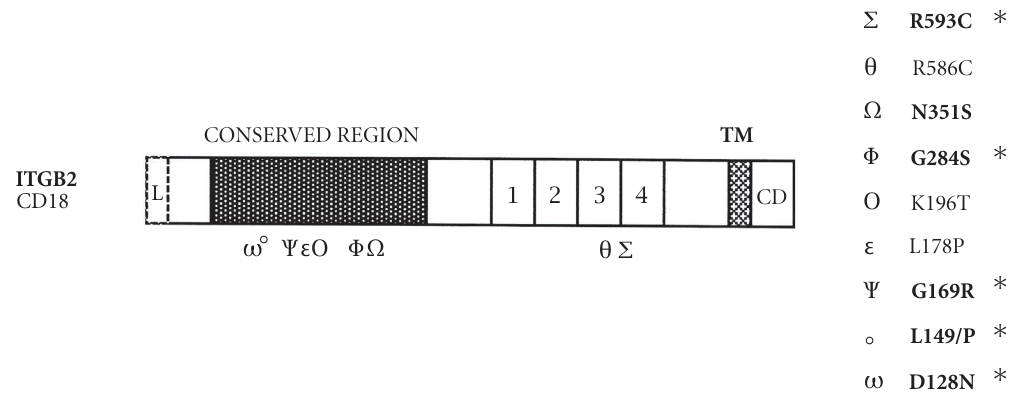
Figure 5: Localization of the missense mutations causing LAD, along the CD18 subunit: most of the mutations causing a single amino-acid substitution are clustered in the NH2 domain 250 residues that are highly conserved among the β integrins ( β 1 – β 8 ). A Greek letter indicates each point mutation. Asterisks (*) indicate potential hot spot mutations 1, 2, 3, 4 are the cystein rich repeats, TM = transmembrane domain, CD = cytoplasmic